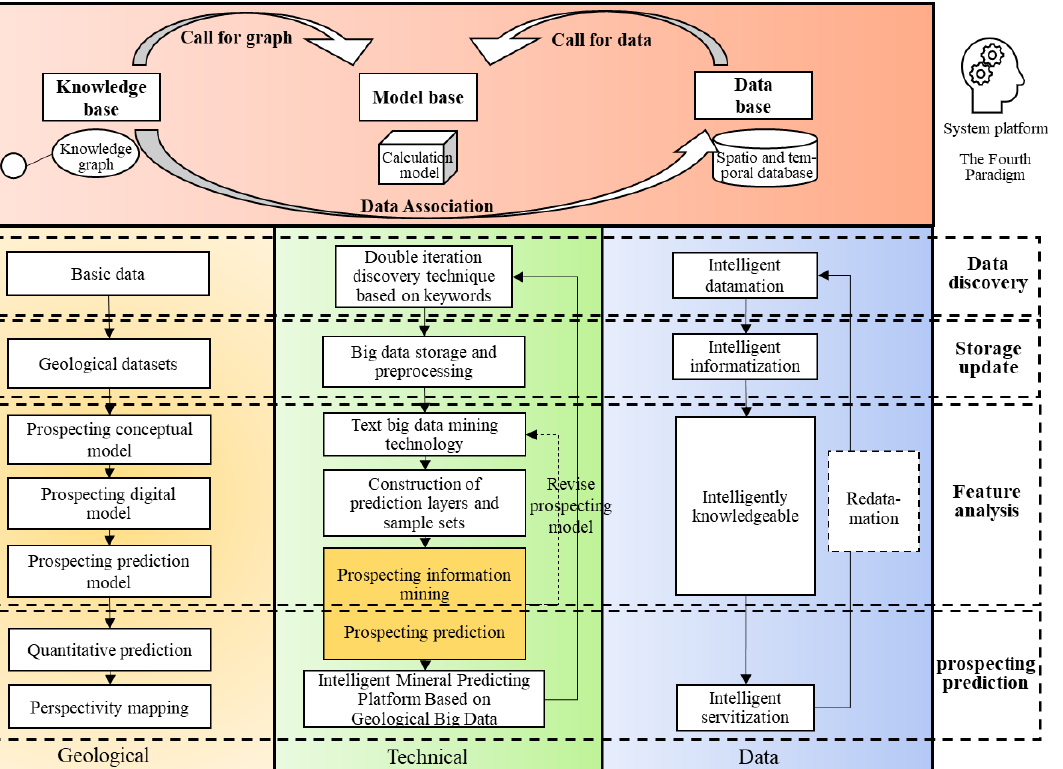
Figure 2. Theoretical method framework of intelligent prospecting based on geological big data.